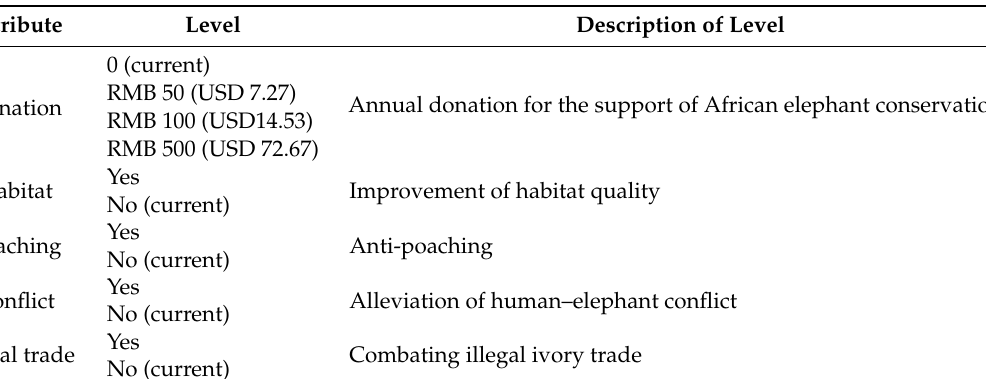
Table 1. Attributes and levels used in the choice